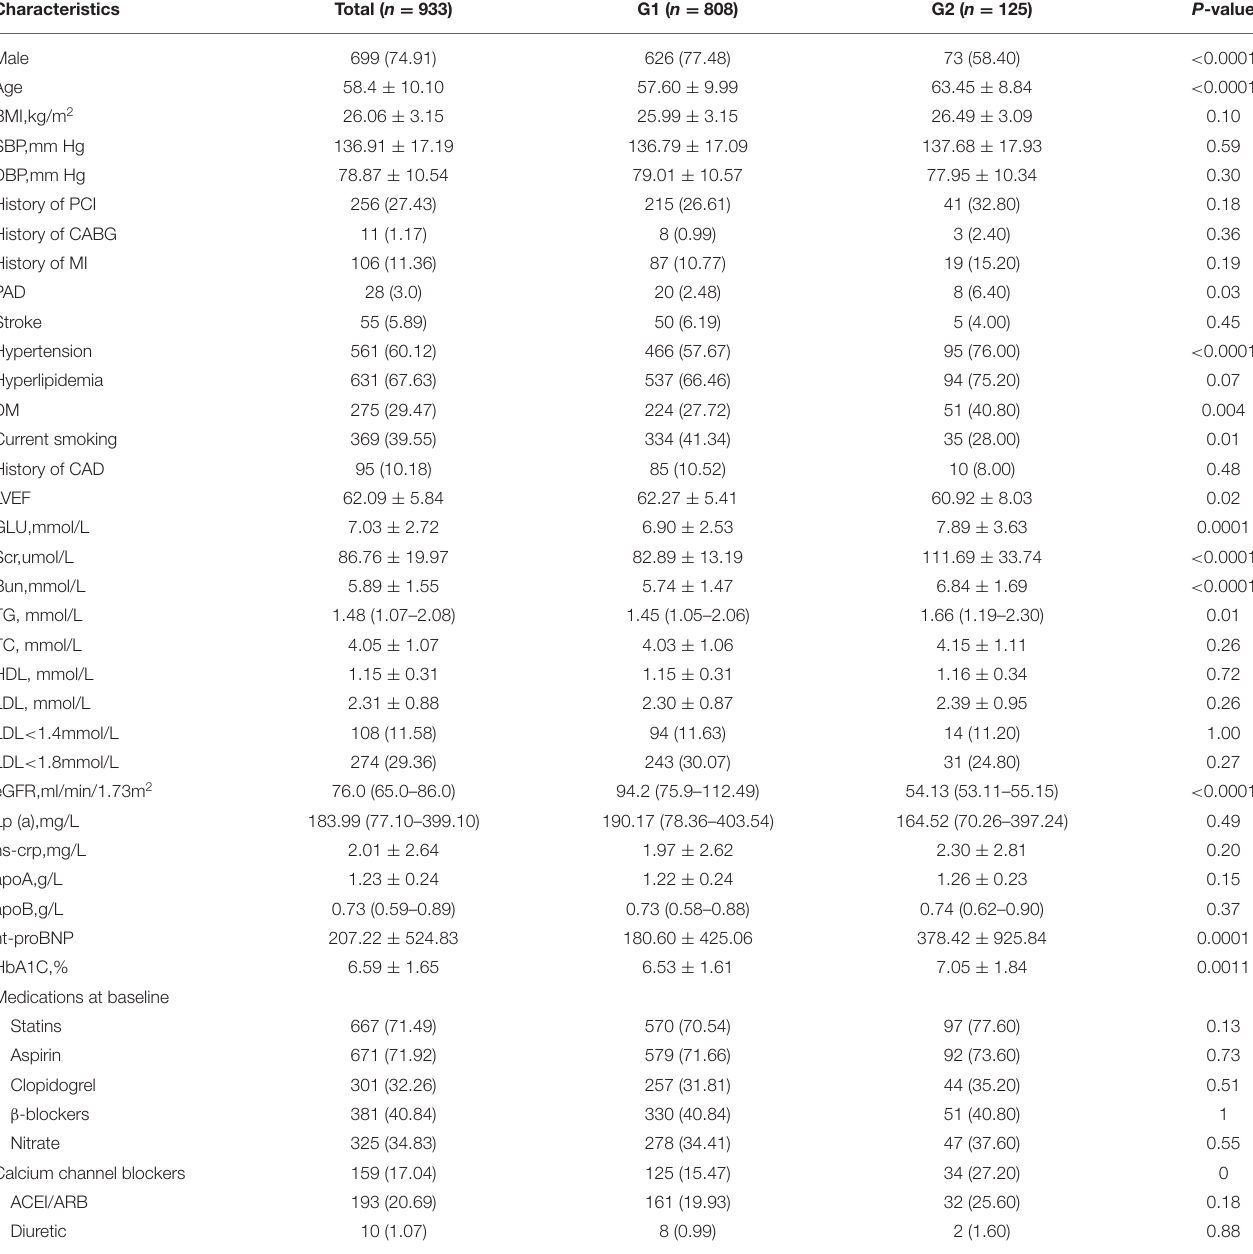
TABLE 1 | The baseline characteristics of total participants including G1 and G2.